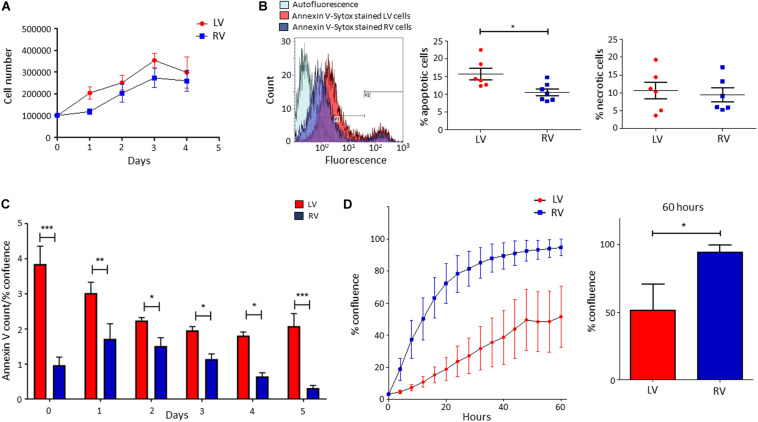
Higher apoptosis in growth conditions characterizes left ventricle (LV) cardiac mesenchymal stromal cells (C-MSC) with respect to right ventricle (RV) cells. RV C-MSC show greater motility when compared to LV cells. (A) The growth curves of LV and RV C-MSC in the culture medium are reported. Cells were cultured for 4 days, and the number of cells was counted every 24 h. No differences in growth curve slopes have been obtained. n = 6 each (linear regression slope comparison). (B) The percentage of apoptotic and necrotic cells was evaluated in the culture medium. In the left panel, representative flow cytometry histograms comparing LV and RV C-MSC patterns are shown. As shown in the right graphs, a higher percentage of apoptotic (measured in #1 interval) LV C-MSC than RV cells has been found. No differences between the necrotic (measured in #2 interval) cell amount were recorded. n = 6 each; *p < 0.05 (paired t-test). (C) The apoptosis rate of LV and RV C-MSC for different time-points is reported. Cells were cultured for 5 days in growth medium. The Annexin V count normalized on the percentage of confluence is shown. For all the time-points, a trend of higher apoptosis was measured in LV cells, significantly different from RV C-MSC apoptotic rate at days 0, 1, 2, 3, 4, and 5. n = 6 each; *p < 0.05, **p < 0.01, ***p < 0.001 (two-way ANOVA). (D) The mean values of confluence percentage of LV and RV cells during scratch wound assay are reported (left panel). Higher motility of RV C-MSC, if compared to LV cells, has been found. Cell confluence was recorded for 60 h. The right graph depicts the difference in confluence percentage at 60 h. n = 6 each; *p < 0.05 (paired t-test).